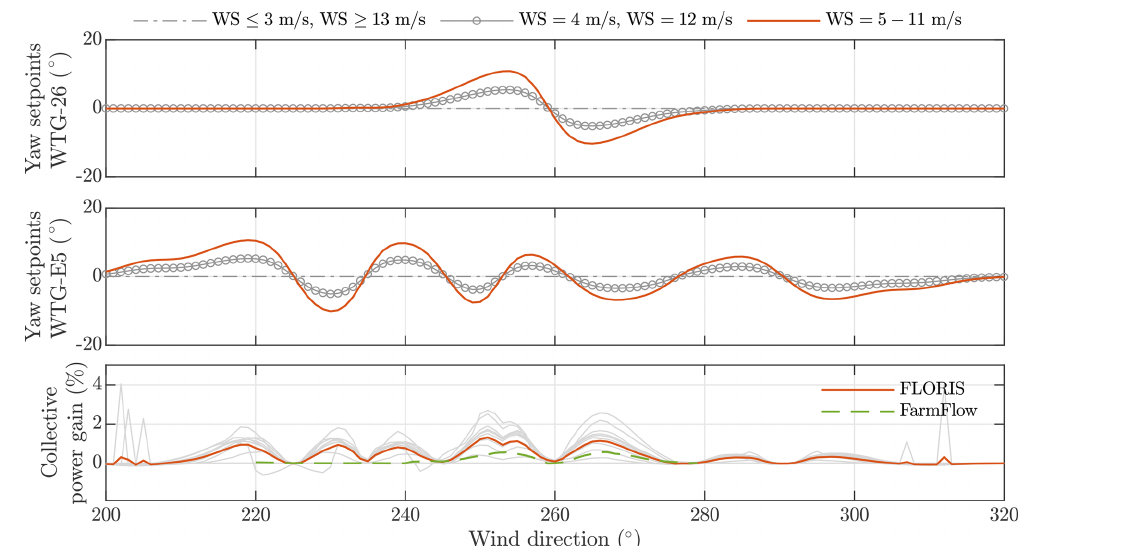
Figure A2. The optimal turbine yaw angle setpoints for WTG 26 and E5 for a freestream turbulence intensity of 18.0%. The averaged collective power gain of WTG 26, WTG E5, and the downstream machine (WTG 10, 11, 12, or 31) is shown as the solid orange line (FLORIS) and the dashed green line (FarmFlow) in the bottom plot. The gray lines therein represent the predicted gains for one wind speed by